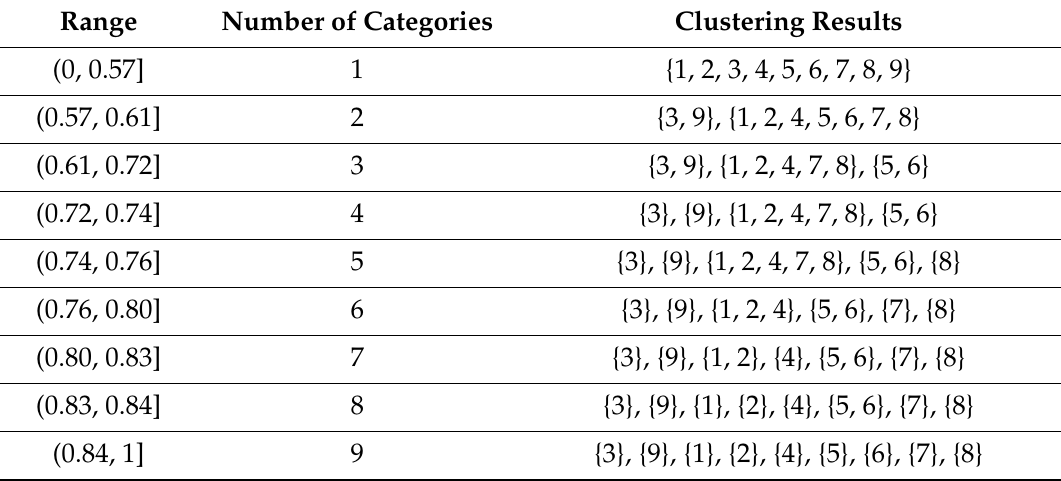
Table 10. Clustering